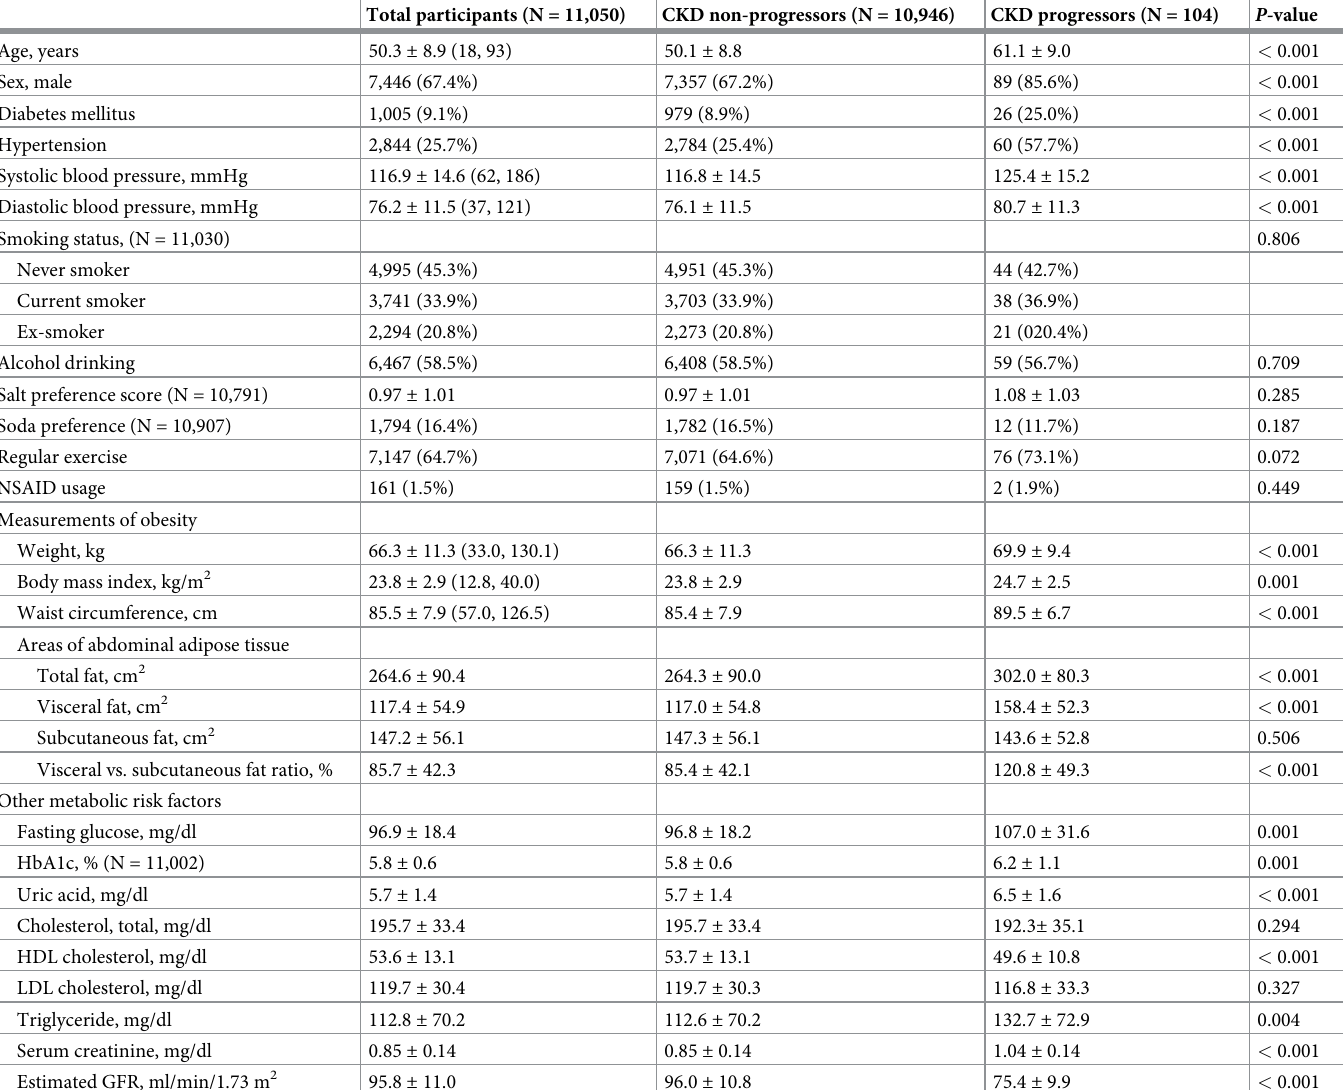
Table 1. Baseline characteristics of study subjects according to the development of chronic kidney disease. Total participants (N =